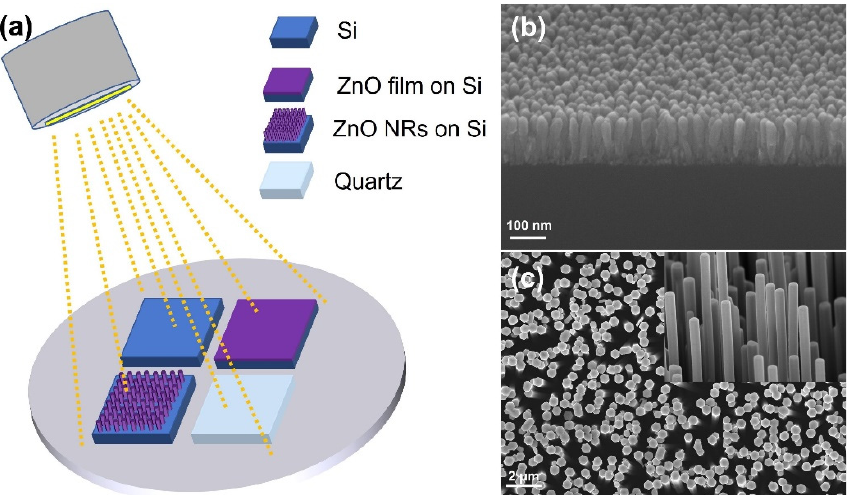
Figure 1. ( a ) Schematic illustration of Au sputtering on four kinds of substrates; ( b ) Tilted cross- section SEM image of ZnO film before Au sputtering; ( c ) Top-view SEM image of ZnO nanorods arrays before Au sputtering; the inset is the corresponding side-view SEM image of individual ZnO nanorods.